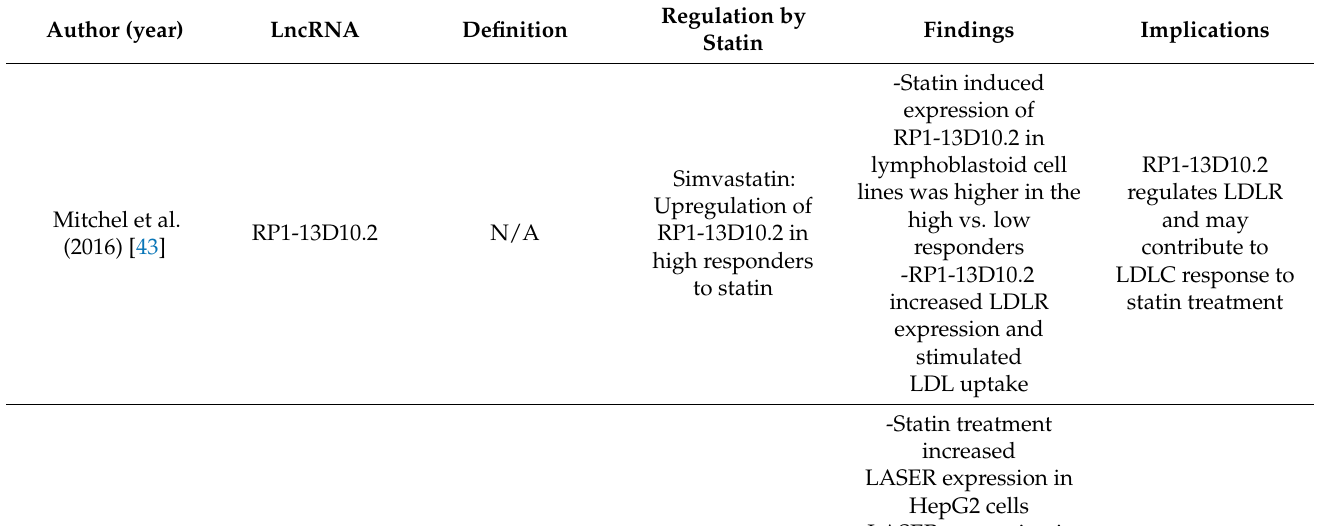
Table 2. Regulation of lncRNAs by